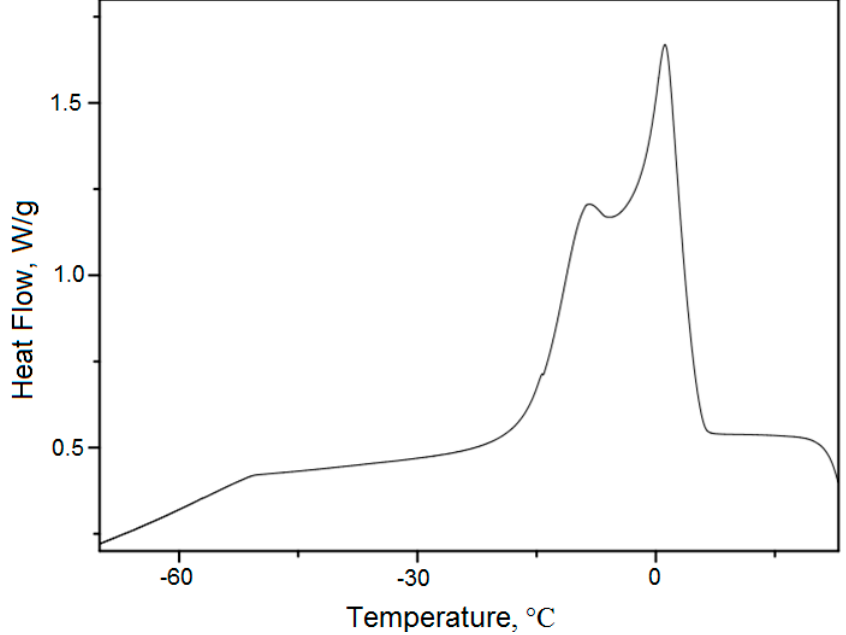
Figure 4. Cooling of babassu oil on an oxidative atmosphere of nitrogen under almost quasi-isothermal